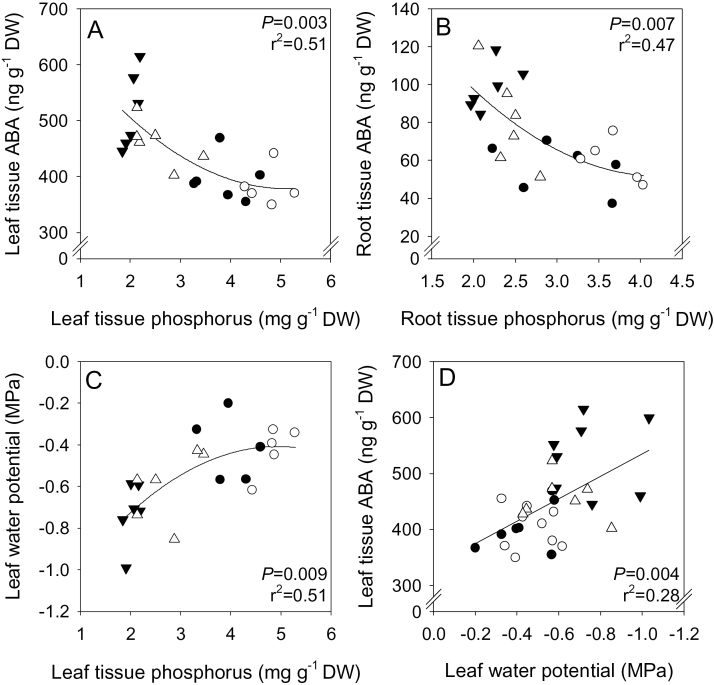
Relationship between leaf (A) and root (B) tissue ABA concentration and phosphorus concentration, leaf water potential and leaf tissue phosphorus concentration (C), and leaf water potential and leaf ABA concentration (D) in limed (filled triangles), limed + P fertilizer (open triangles), unlimed (filled circles), and unlimed + P fertilizer (open circles) Pisum sativum. Data points represent individual plants, with second-order polynomial (A, B, C) and linear (D) regression lines fitted, with P-values and r
2 reported.